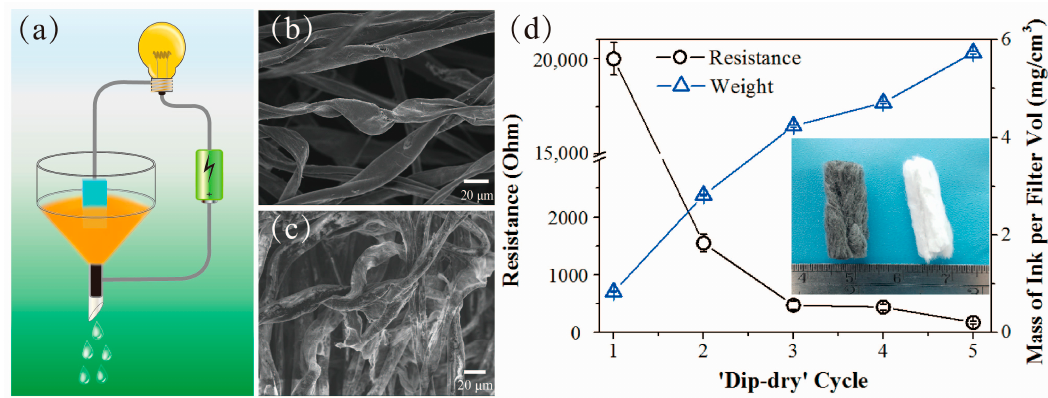
Figure 1. ( a ) Schematic illustration of the electrochemical cotton filtration device; FESEM images of ( b ) a pristine cotton and ( c ) a CNT-coated cotton filter; ( d ) change of filter resistance and weight of cotton filter as a function of ‘dip–dry’ cycles. The inset in ( d ) is digital pictures of a pristine cotton filter (white, right) and a CNT-coated cotton filter (black,